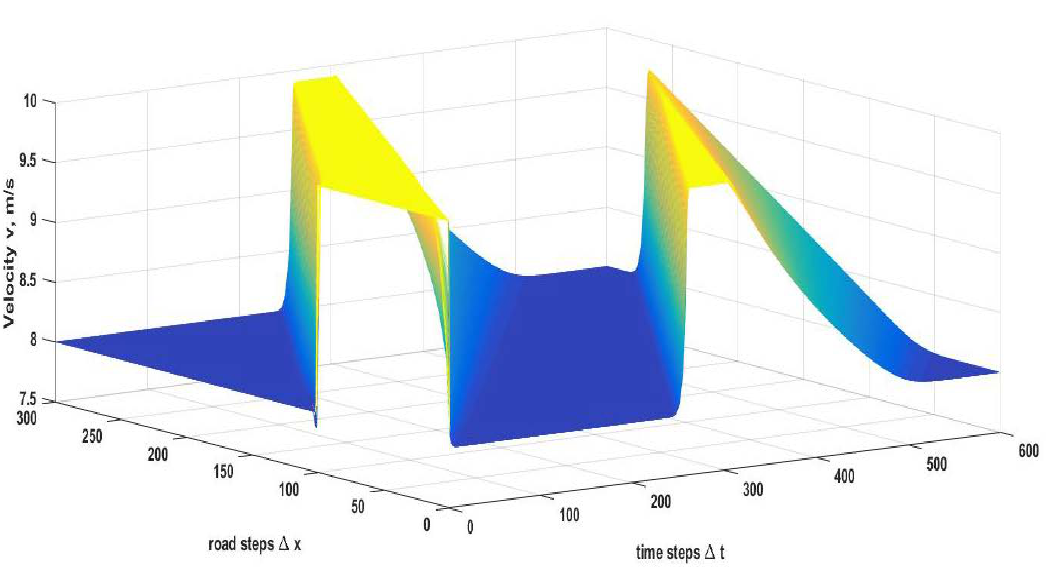
Figure 5. Velocity with the proposed model on a 300 m circular road for 60 s with τ = 2.5 s and distance headway h = 20 m.